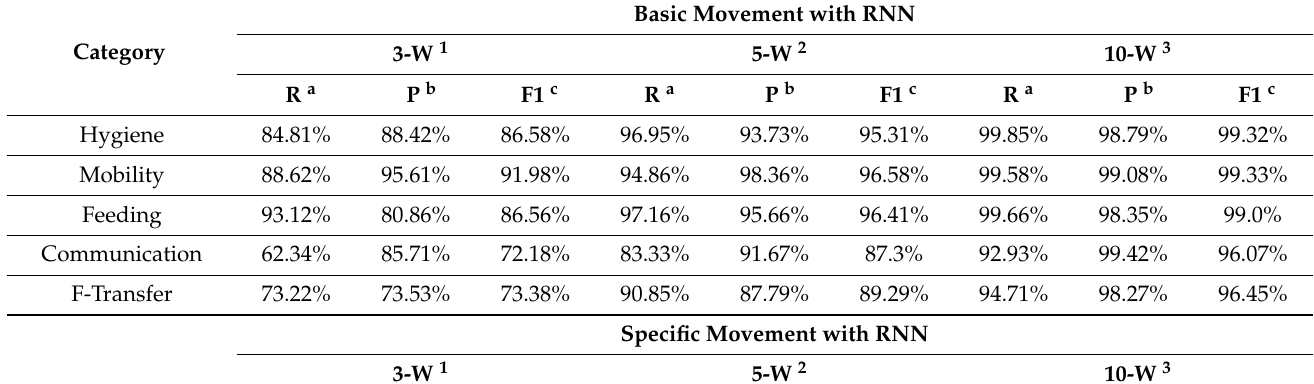
Table 3. Best result of basic and specific movement of wrist-worn dataset 3, 5, 10-s window using